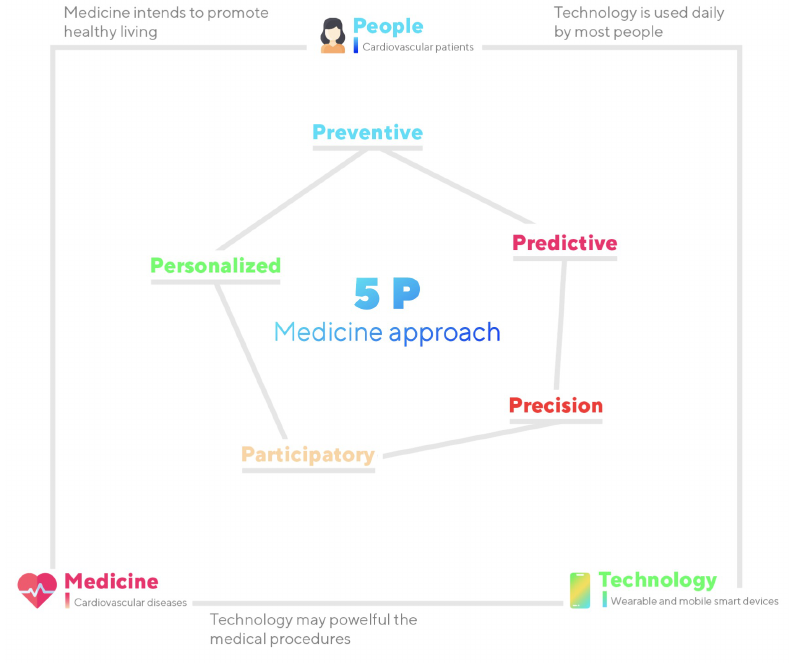
Figure 1. Workflow of the proposed